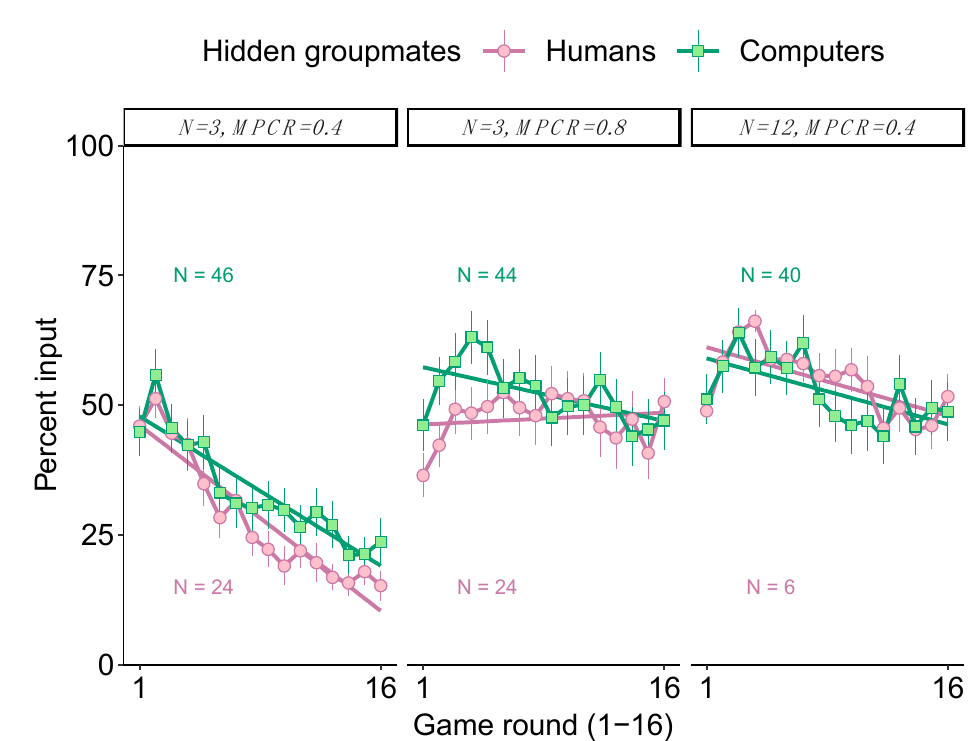
Figure 2. Learning in a black box, either with hidden human or computerised groupmates. We varied both the group size (N) and the benefit of contributing (MPCR) across three black boxes. Participants played all three black boxes, in counter-balanced order, but here we only show naïve behaviour (their first black box). Data show the mean contribution per round, with 95% confidence intervals based on the group means (in games with computers, the independent group is just one individual). The rate of learning was broadly similar regardless of playing with humans or computers. The linear regressions do not account for random effects/repeated measures and are therefore for illustration purposes only. The figures are annotated with the sample sizes of independent replicates (groups of humans or individuals grouped with computers). Table 1. Contributions over time. Analysis of how contributions (“inputs”) change during the game for each black box depending on if groupmates were humans or computers. Generalised linear mixed model with a binomial logit link, and random intercepts for both groups and individuals and random slopes for individuals. N = 3, MPCR = 0.4 N = 3, MPCR = 0.8 N = 12, MPCR =